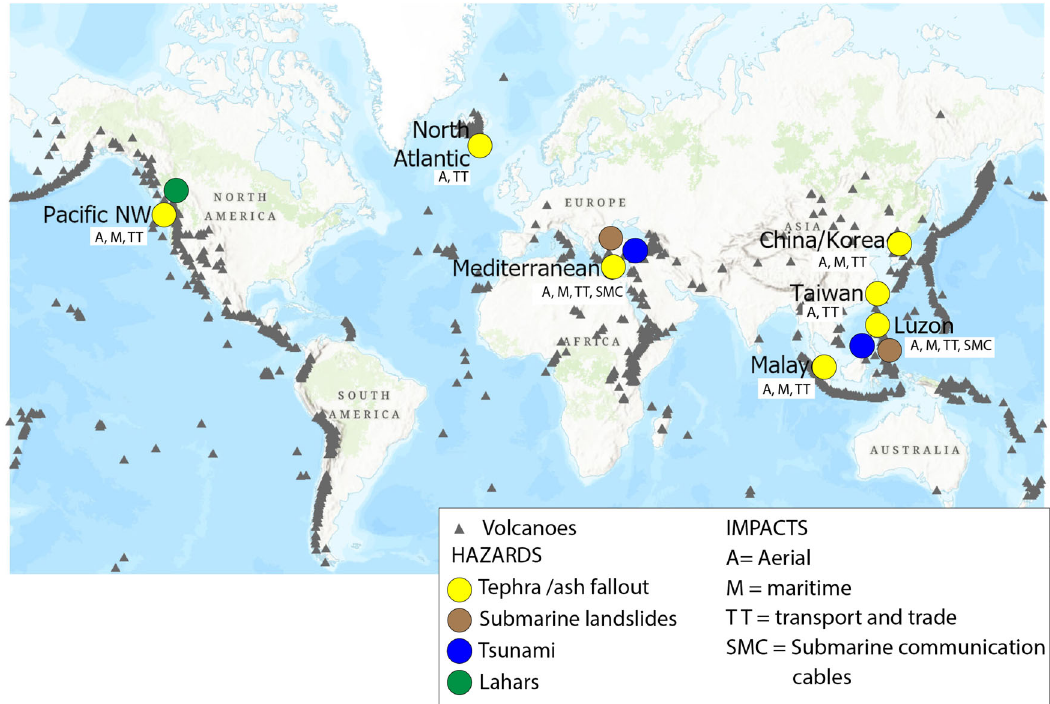
Fig. 2 Seven global pinch points. Map of regions or pinch points where clustering of critical systems and infrastructures converge with regions of lower- magnitude volcanic activity (volcanic explosivity index 3 – 6). These pinch points are presented with the likely associated volcanic hazard activities in circles; where yellow is tephra/ash fallout, brown is submarine landslides, blue are tsunamis, and green are lahars. Each pinch point also includes the potentially impacted systems, including aerial (A), maritime (M), trade and transportation networks (TT), and submarine cables